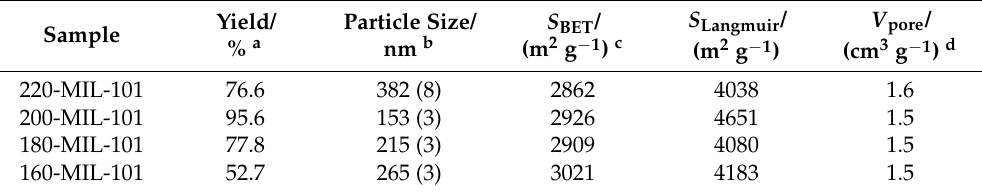
Table 1. Yield, particle size, surface area, and pore volume of samples